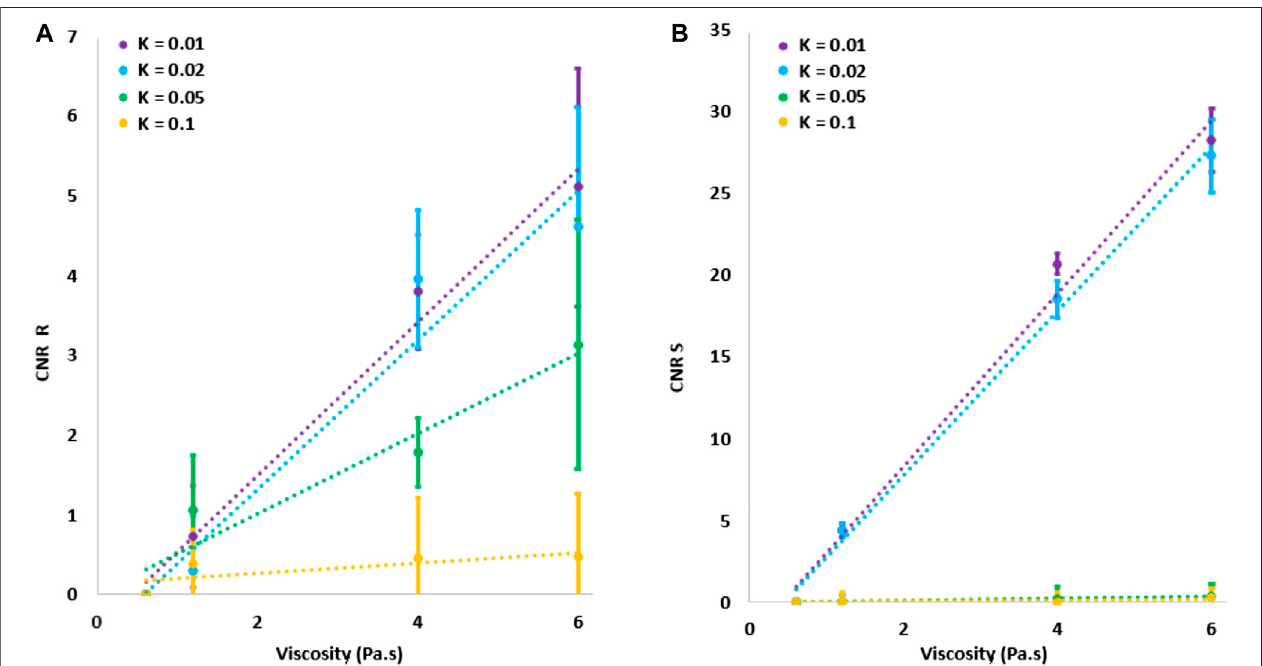
FIGURE 4 | Contrast-to-noise ratio for either R and S parameters in function of the viscosity for different levels of noise. Error bars represent standard deviations over twenty repetitions.